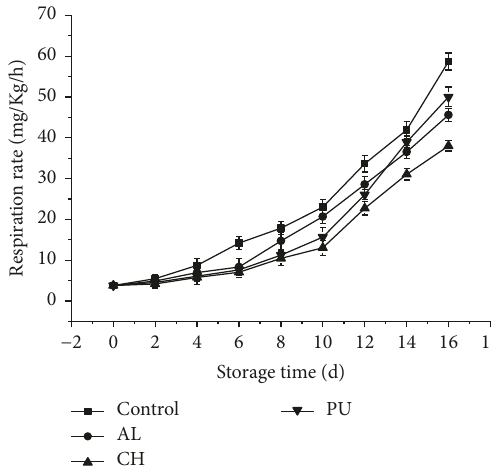
Figure 3: Effects of three different polysaccharide-based edible coatings on respiration rate of